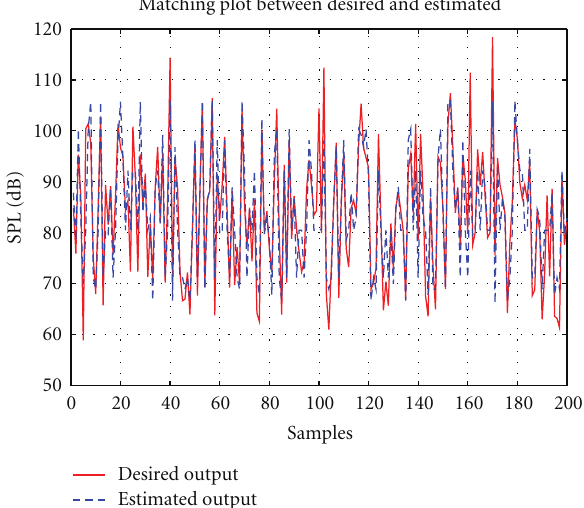
Figure 7: Prediction performance of PPN system for 200 samples.